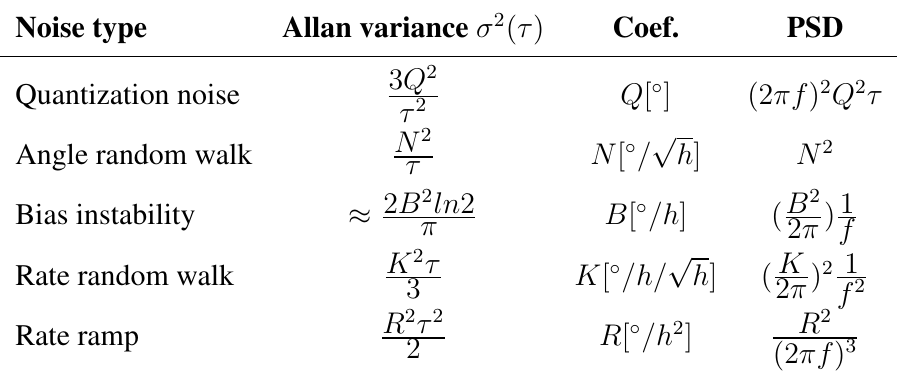
Table 3. Dominant stochastic errors in inertial